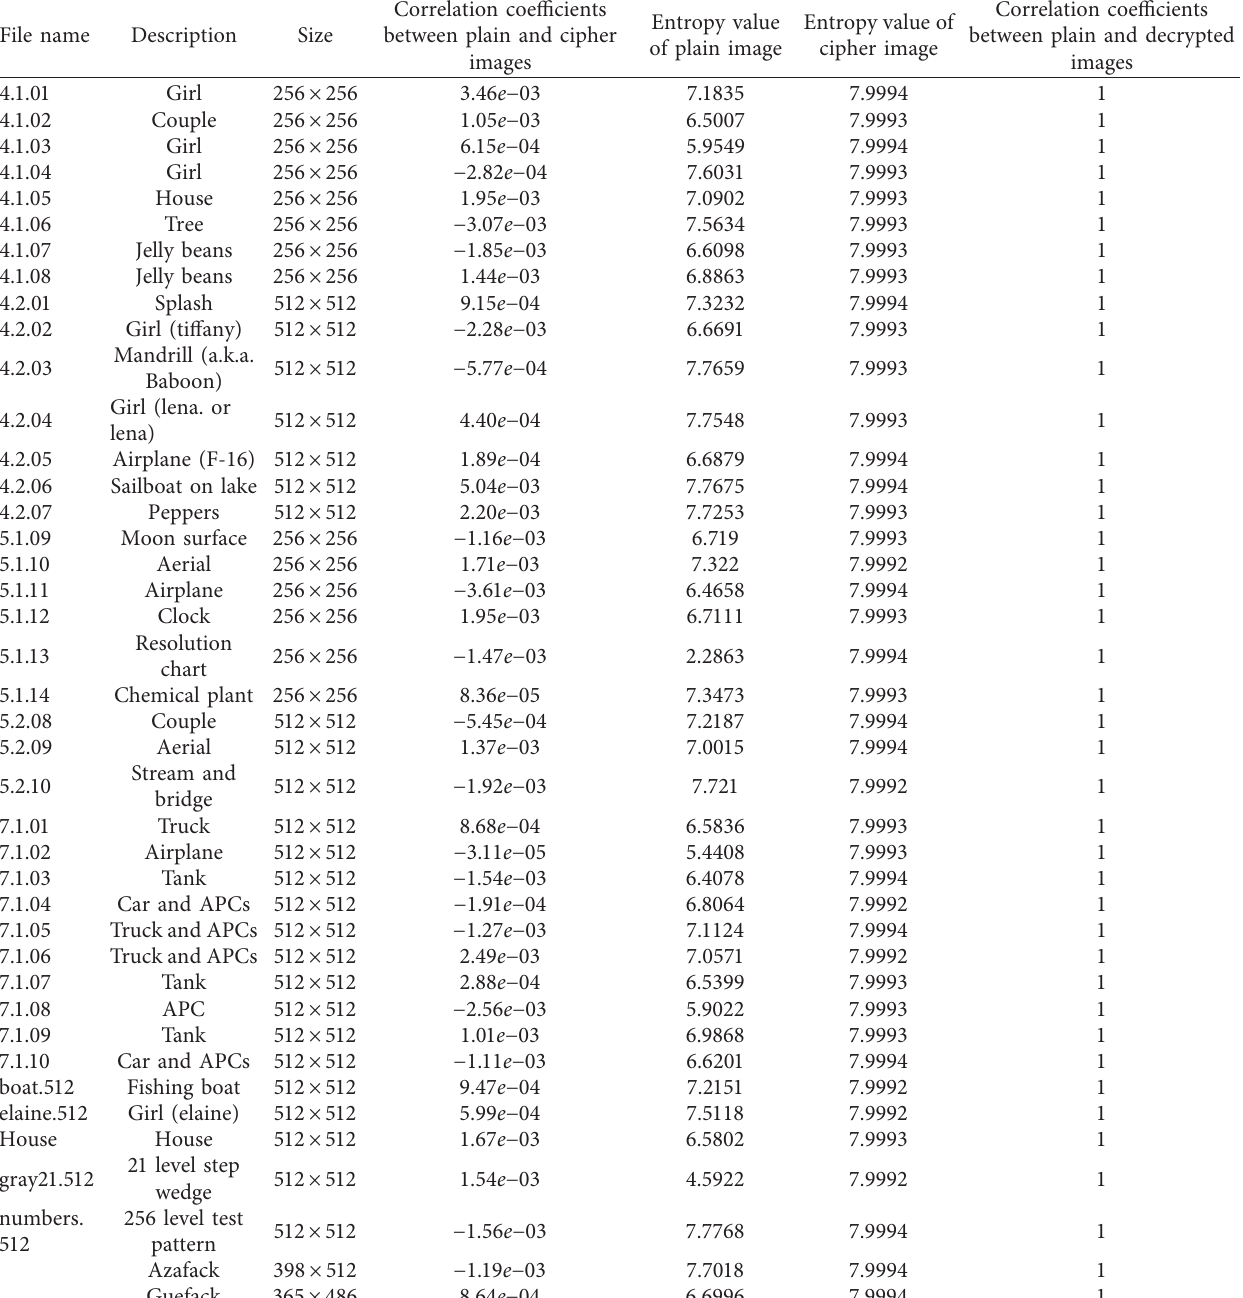
Table 4: Correlation coefficients and entropy information of some nonmedical